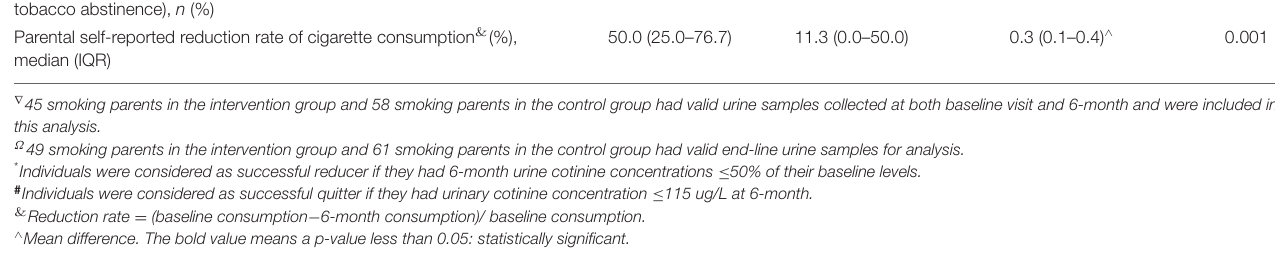
Intervention (N = 105)